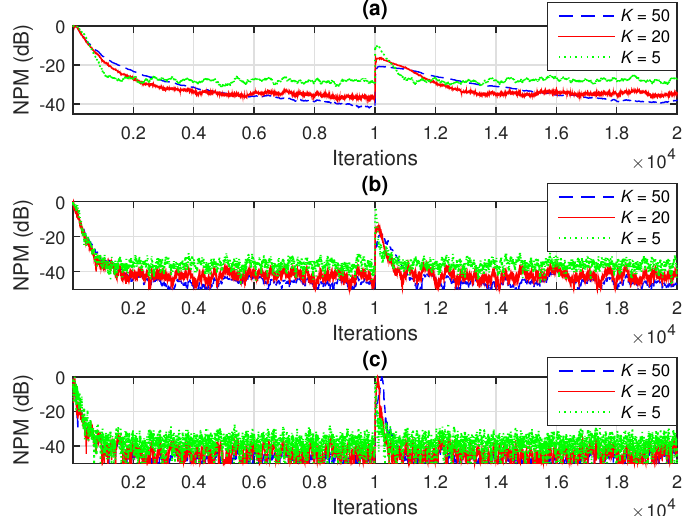
Figure 3. Normalized projection misalignment (NPM) evaluated based on (55)–(57), in dB, for the identification of the individual impulse responses from Figure 2a–c, using the RLS-TF algorithm with different values of the forgetting factors λ i = 1 − 1/ ( KL i ) , i = 1,2,3 (varying the value of K ): (cid:104) (cid:105) (cid:104) (cid:105) (cid:104) (cid:105) h 1 , (cid:98) h 1 ( n ) h 2 , (cid:98) h 2 ( n ) h 3 , (cid:98) h 3 ( n ) ( a ) NPM , ( b ) NPM , and ( c ) NPM